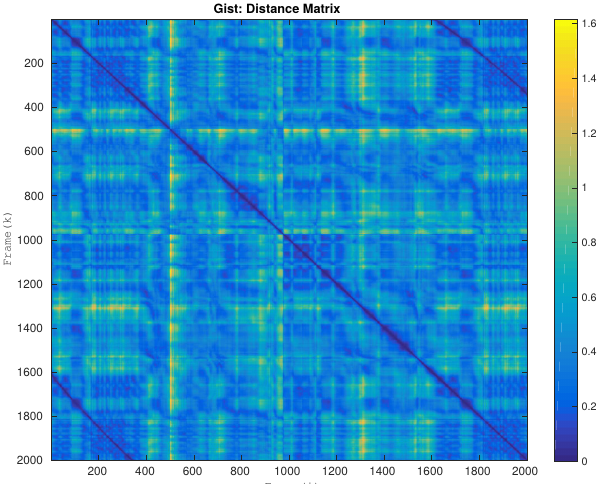
Figure 3: Distance matrix showing similarity among individual scenes. The values close to 0 show that places are closer on the perceptual axis in the space characterized by Gist features, whereas brighter re- gions depict distant scenes.